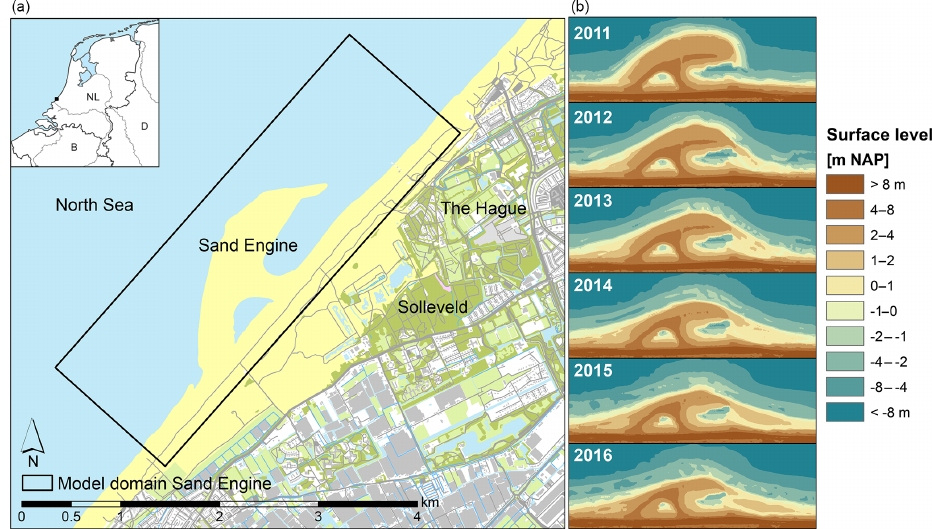
Figure 1. Map of the study area with the model domain (a) , and the change of the surface level in the study area (morphological development) between 2011 and 2016 (b) in metres with respect to the NAP datum, which is approximately equal to mean sea level.